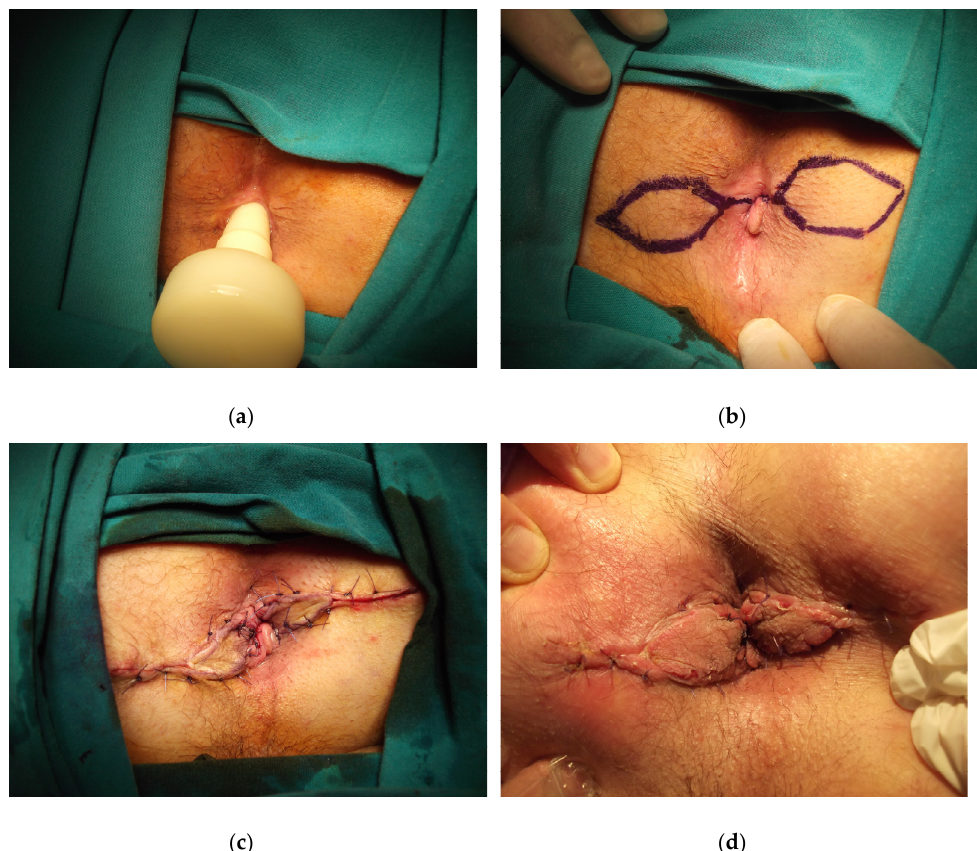
Figure 5. Bilateral diamond flap anoplasty in severe anal stenosis is shown, ( a ) the anal caliber is measured using an anal calibrator, ( b ) the technique is drawn, ( c ) the postoperative image after anoplasty, ( d ) the image in postoperative 1st week.